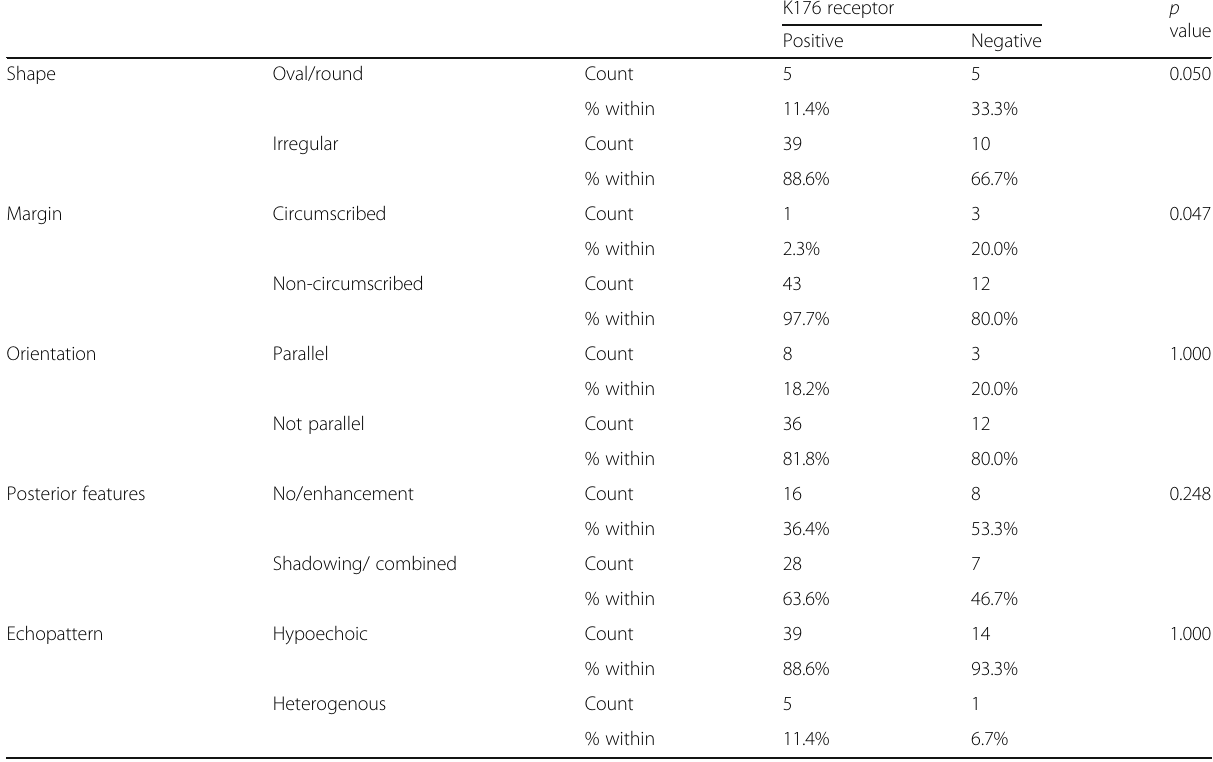
Table 7 Association between status of Ki67 and ultrasound findings of breast